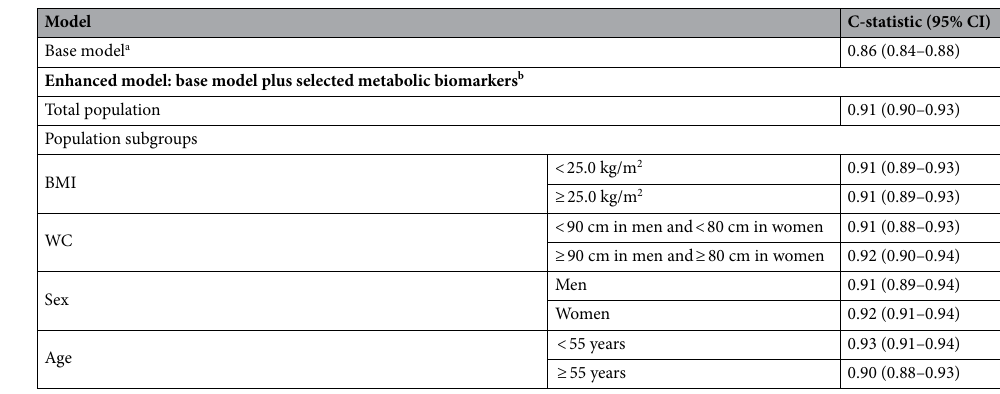
Table 2. Discriminatory ability of prediction models for incident type 2 diabetes. BMI body mass index, WC waist circumference. a Age, sex, study area, fasting time, body mass index, family history of diabetes, education, blood pressure, resting heart rate, plasma glucose, triglycerides, statin use. b Concentrations of linoleic acid, docosahexaenoic acid, 3-hydroxybutyrate, apolipoprotein A-I, esterified cholesterol, free cholesterol in very small VLDL, glycoprotein acetyls, lactate, phosphatidylcholine, phospholipids in IDL, total cholesterol in very large HDL, total lipids in large HDL, total lipids in small VLDL, triglycerides in large HDL, triglycerides in small HDL, valine, ratios of docosahexaenoic acid to total fatty acids, apolipoprotein B to apolipoprotein A-I, cholesterol esters to total lipids in medium HDL, cholesterol esters to total lipids in small VLDL, free cholesterol to total lipids in large HDL, free cholesterol to total lipids in medium HDL, free cholesterol to total lipids in small HDL, free cholesterol to total lipids in very small VLDL, phospholipids to total lipids in large LDL, phospholipids to total lipids in large VLDL, phospholipids to total lipids in small HDL, triglycerides to total lipids in IDL, triglycerides to total lipids in small VLDL, mean HDL particle